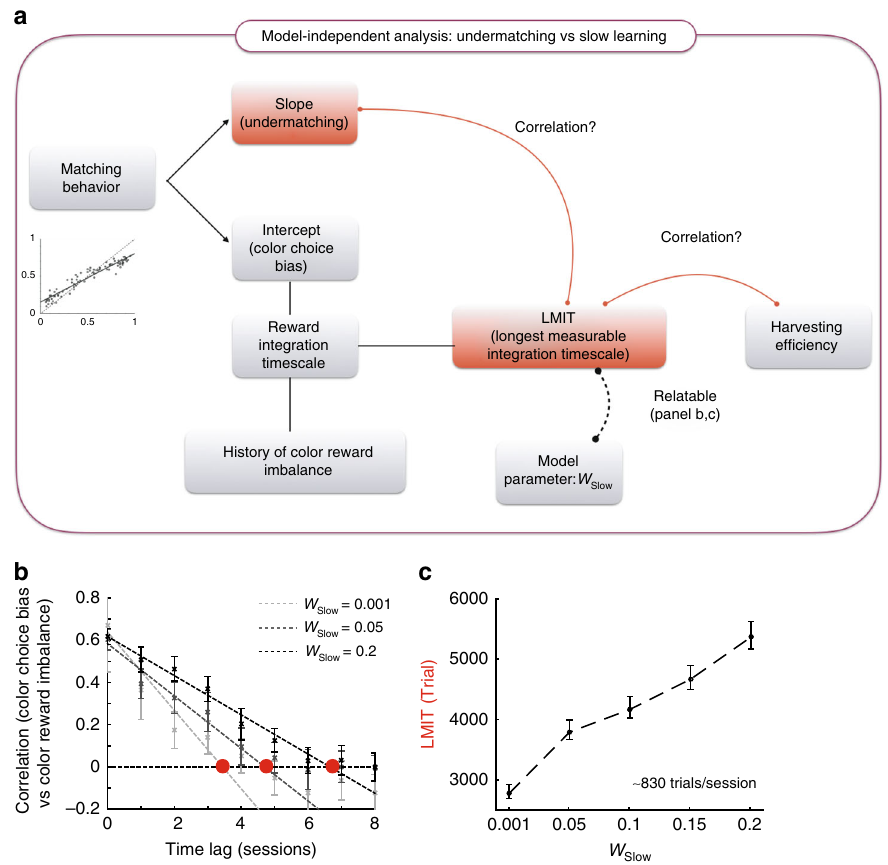
Fig. 6 The model-independent analysis of integration over long timescales: the longest measurable integration timescale (LMIT). a The schematic of the analysis. From the plots describing matching behavior (see Fig. 1b), we fi t a line to the datapoints and we measure its slope (undermatching) and its intercept at x = 0.5 (color choice bias). We also estimate session-by-session color reward imbalance that we de fi ned as the imbalance between rewards obtained from two color targets. We then estimate how long ago color reward imbalance can in fl uence future color choice bias by lagged correlation analysis, which we refer to as the longest measurable integration timescale (LMIT). Although this is a model-independent measure, it is related to our model parameter w Slow . The motivation for introducing the LMIT is to show that the LMIT co-varies with the undermatching slope over time, providing direct evidence for the link between undermatching behavior and reward history integration over very long timescales. b Precise de fi nition of the LMIT and its dependence on the relative weight w Slow of the slow integrator of the model (simulated data). The lagged correlation between color choice bias and color reward imbalance are estimated with data simulated using the model in Fig. 2a employing different relative weights of the slow integrator w Slow . The correlation decays as the time-lag between the color choice bias and the color reward imbalance increases. The correlation points are fi tted by a line using weighted linear regression (dotted lines), and the LMIT is de fi ned by the point at which the fi tted line crosses the zero correlation (red fi lled circles). The correlations are the mean of over 50 simulations and the error bars indicate the standard deviations. The model was simulated over the same reward schedule experienced by Monkey F. The timescales are assumed to be τ Fast = 5 trials and τ Slow = 1000 trials, though the precise choice of timescales is not essential for the results. c The LMIT estimated through simulations vs the weight of long-time constant in the model. The estimated LMIT shows a clear positive correlation with the relative weight of the long timescale w Slow employed in the model simulations. The LMIT is expressed in trials, by converting from sessions using the mean session size. This strong monotonic relationship between w Slow and the LMIT suggests that we can use the LMIT estimate as a proxy for the w Slow estimate, when analyzing experimental